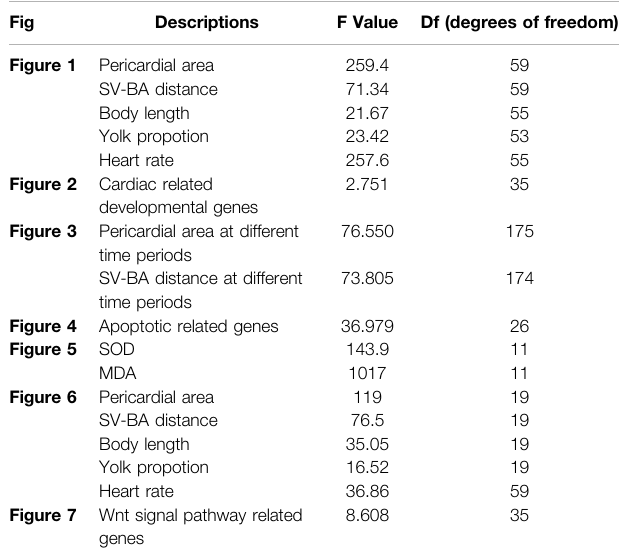
Figure 3 Pericardial area at different time